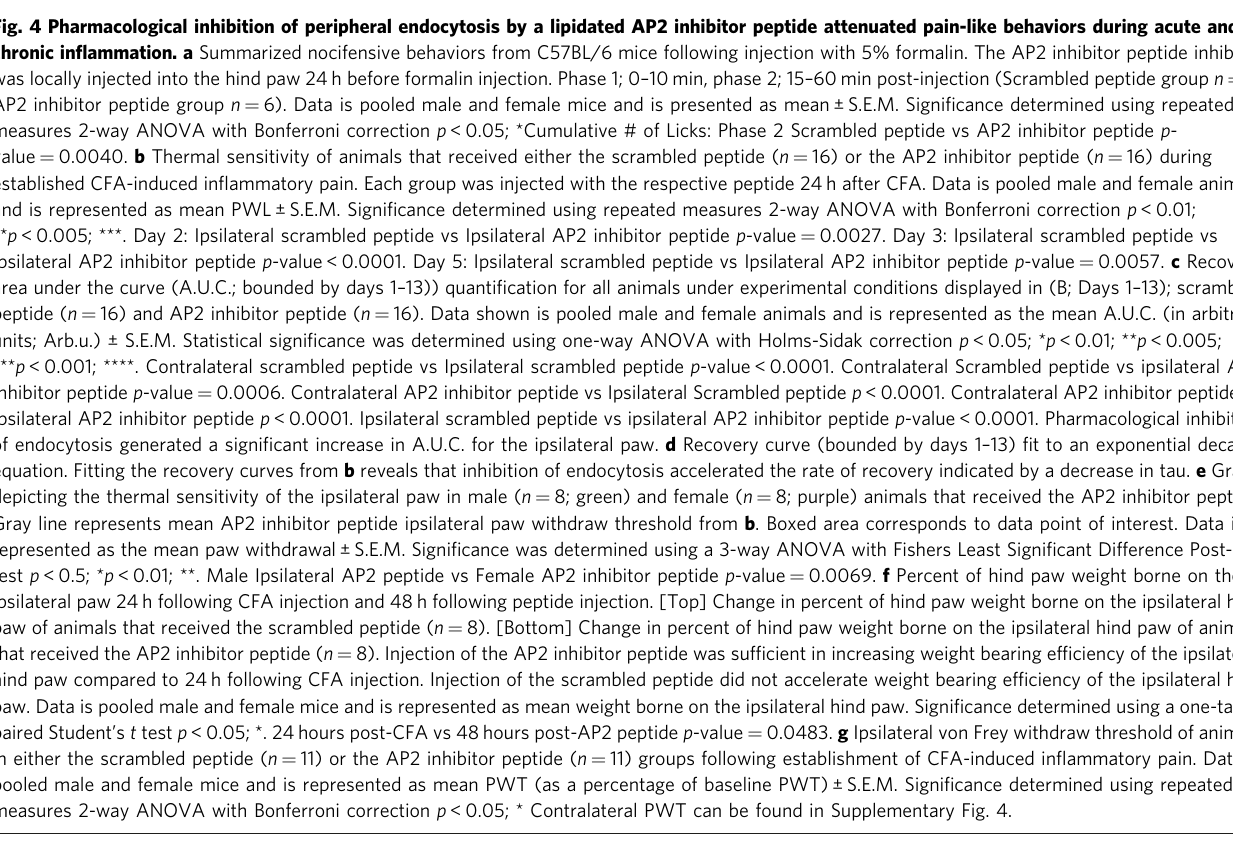
Fig. 4 Pharmacological inhibition of peripheral endocytosis by a lipidated AP2 inhibitor peptide attenuated pain-like behaviors during acute and chronic in fl ammation. a Summarized nocifensive behaviors from C57BL/6 mice following injection with 5% formalin. The AP2 inhibitor peptide inhibitor was locally injected into the hind paw 24 h before formalin injection. Phase 1; 0 – 10 min, phase 2; 15 – 60 min post-injection (Scrambled peptide group n = 6; AP2 inhibitor peptide group n = 6). Data is pooled male and female mice and is presented as mean ± S.E.M. Signi fi cance determined using repeated measures 2-way ANOVA with Bonferroni correction p < 0.05; *Cumulative # of Licks: Phase 2 Scrambled peptide vs AP2 inhibitor peptide p